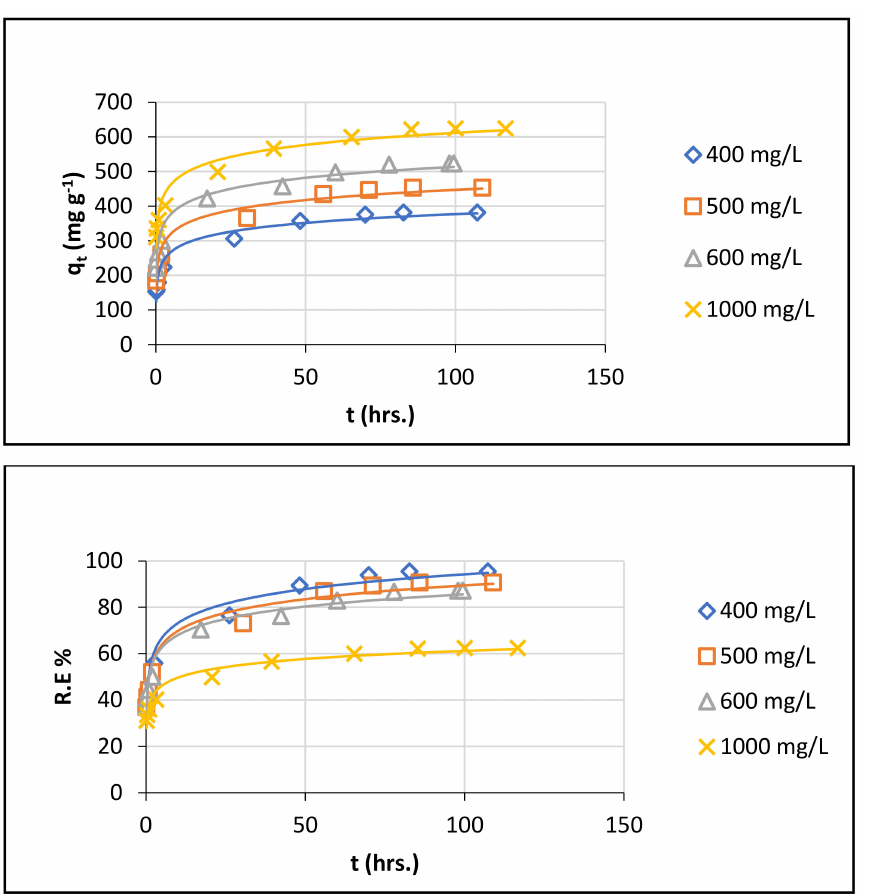
Figure 7. Impact of concentration of CR dye on adsorption onto UCs (Experimental conditions: 50 mg of adsorbent, 50 mL of dye solution, temperature 55 ◦ C and pH 4). At Different